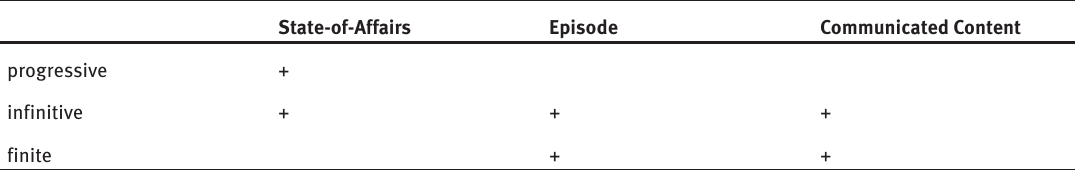
Table 7. Semantic and morphosyntactic types of complement